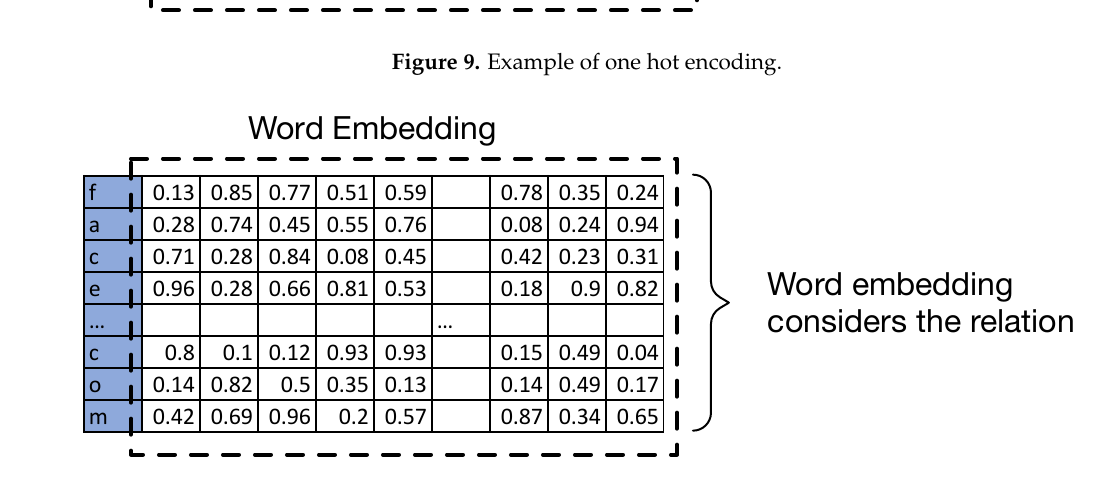
Figure 10. Example of word